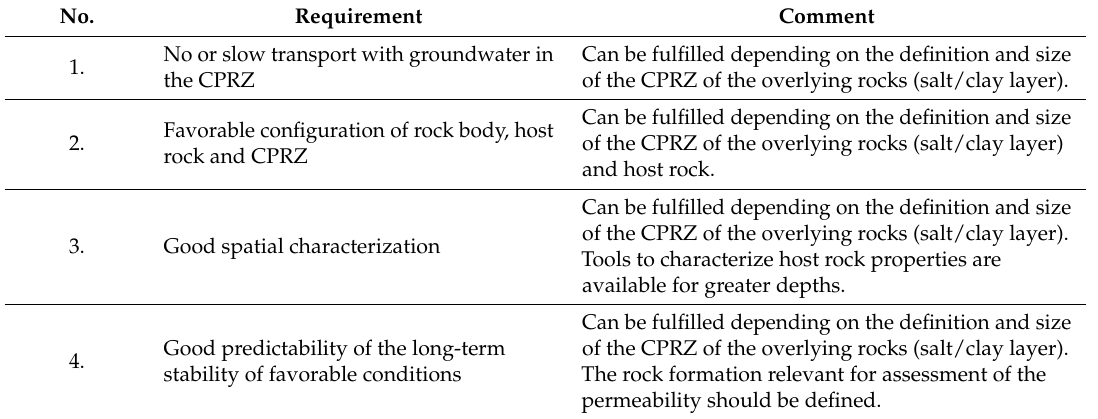
Table 2. Requirements of weighting group 1: Quality of containment and reliability of its evidence.